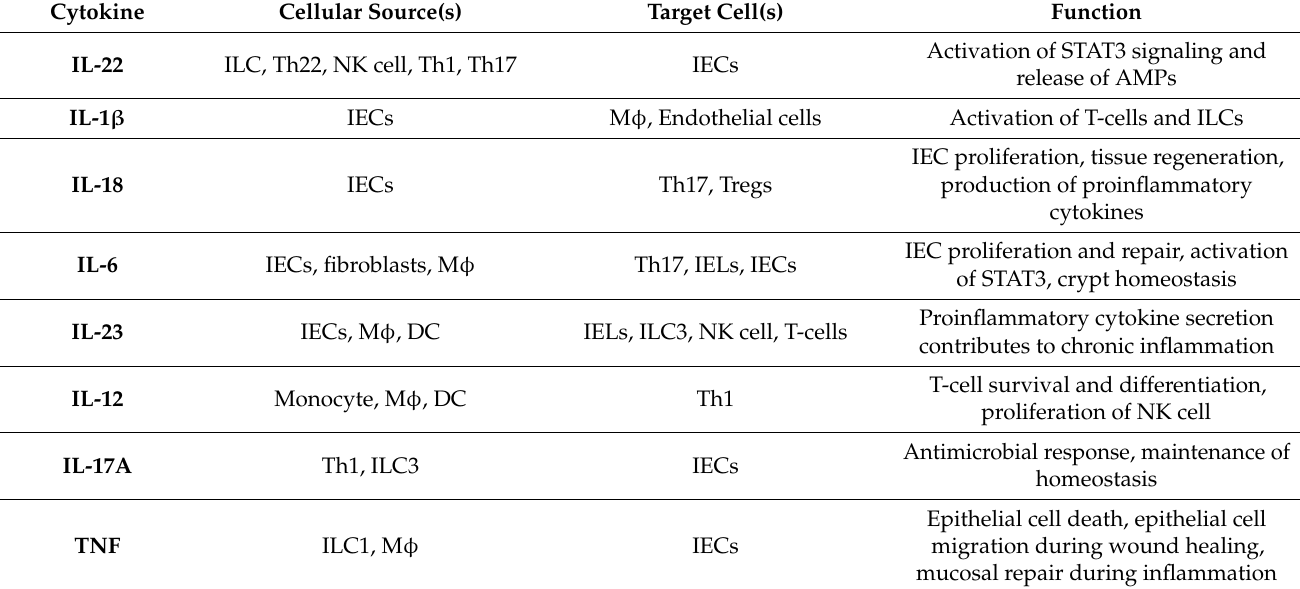
Table 1. A list of major cytokines in intestinal health and pathology along with their specific